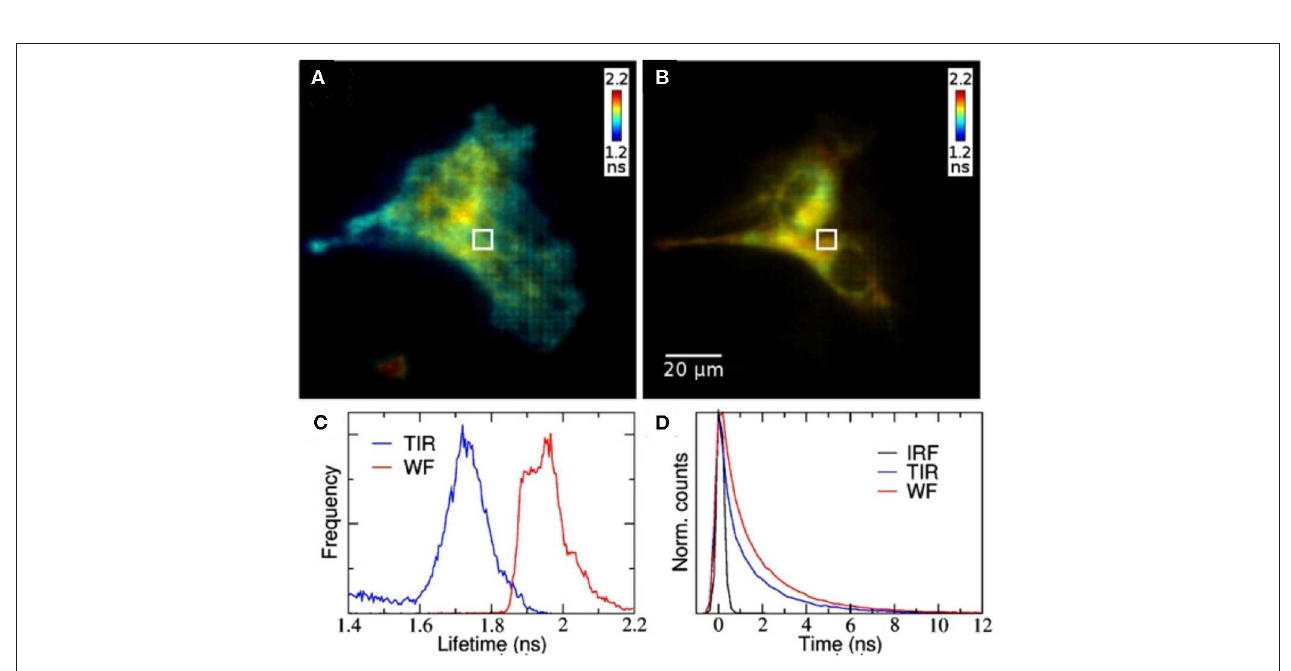
FIGURE 13 | Wide-field TCSPC-based FLIM with TIRF. (A) TIRF and (B) wide-field FLIM images of HeLa cells. (C) Fluorescence lifetime histograms and (D) representative fluorescence decays. The fluorescence lifetime difference between the images is due to selective excitation of the membrane-sensitive dye. Reproduced from Hirvonen et al.